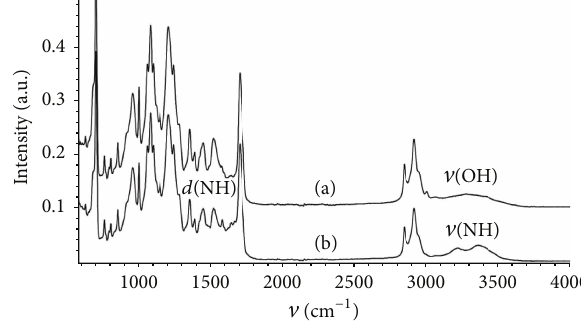
Figure 10: FT-IR spectra from areas showing reduced degradation (a), M1 and M2, when compared with PET controls (b), 1 and